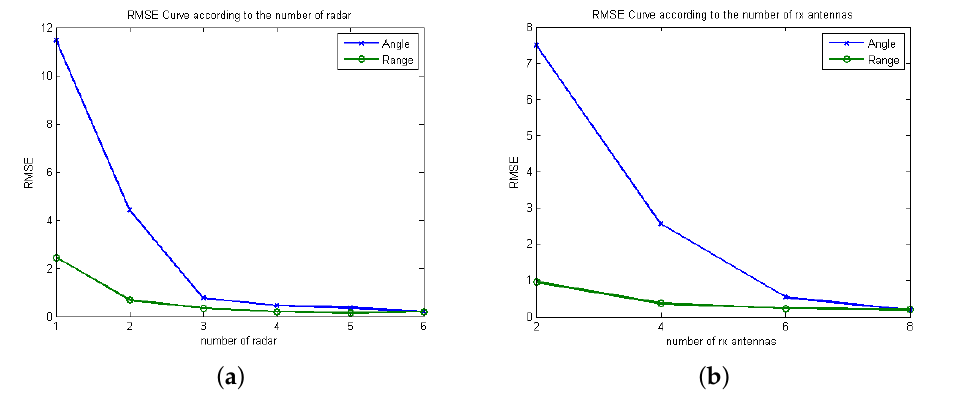
Figure 9. RMSE values of range and angle estimation over various numbers of ( a ) FMCW MIMO radars and ( b ) Rx